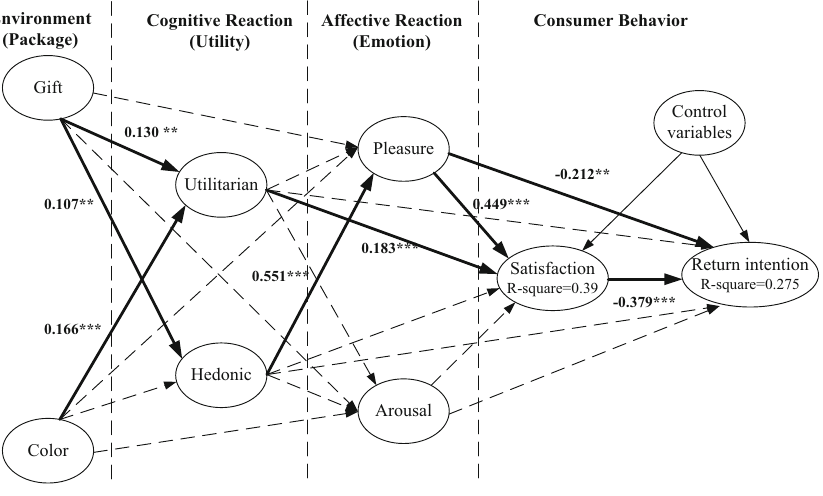
Fig. 6 PLS model and results. * p \ .1; ** p \ .05; *** p \ .01; solid arrows indicate significant paths, while dashed arrows indicate insignificant